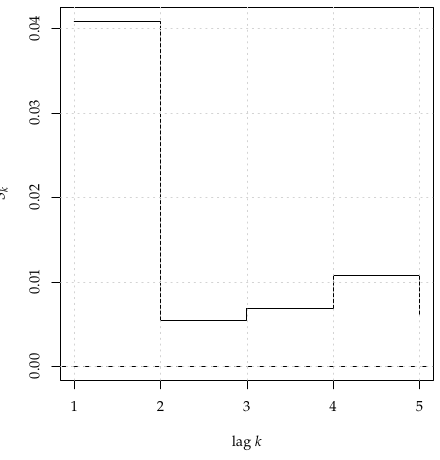
Figure 3. Entropy S k ( k = 1, . . . ,5) computed on a realization of a MA(1)